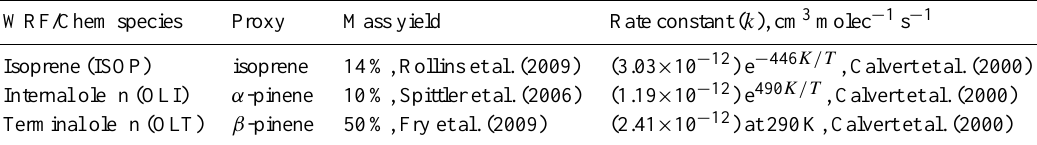
Table 1. Literature SOA mass yields from NO 3 oxidation used in this model.